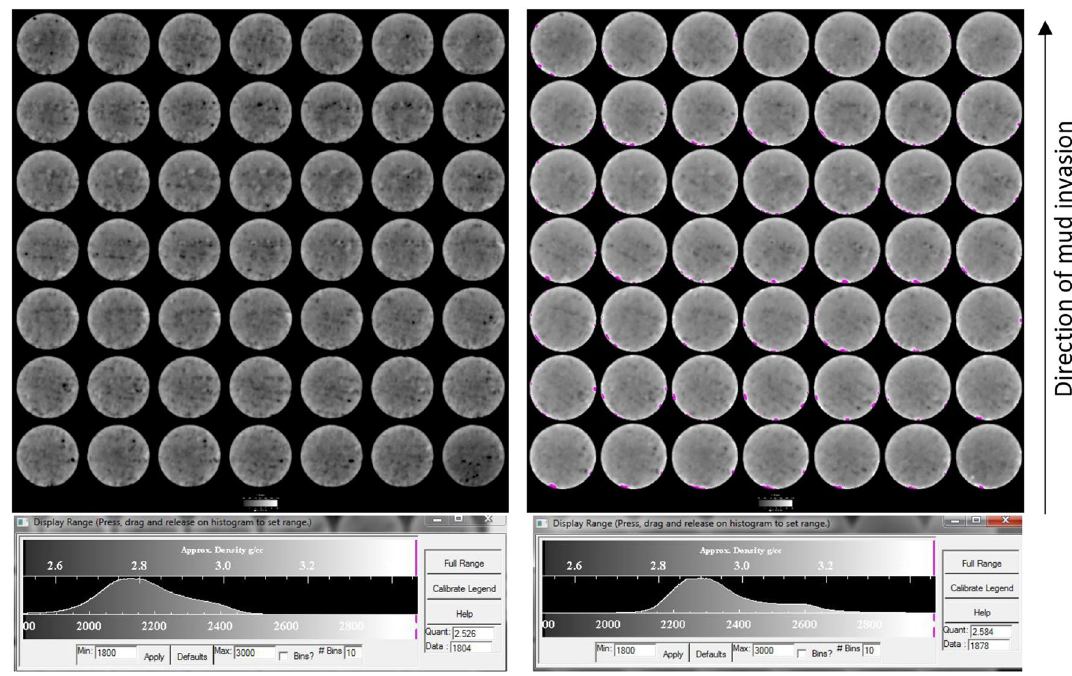
Fig. 6 CT scan of sample 2 showing: (left) pre-filtration-loss slices and (right) post-filtration-loss